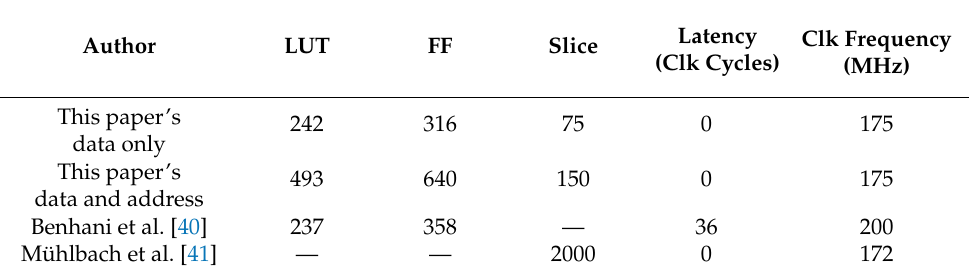
Table 1. Comparison of area and timing results. The results for AXICrypt are for an xc7z020clg484 . Due to the combinational nature of the AXICrypt encryption, it does not have any latency. The sequential part of the core is capable of reaching